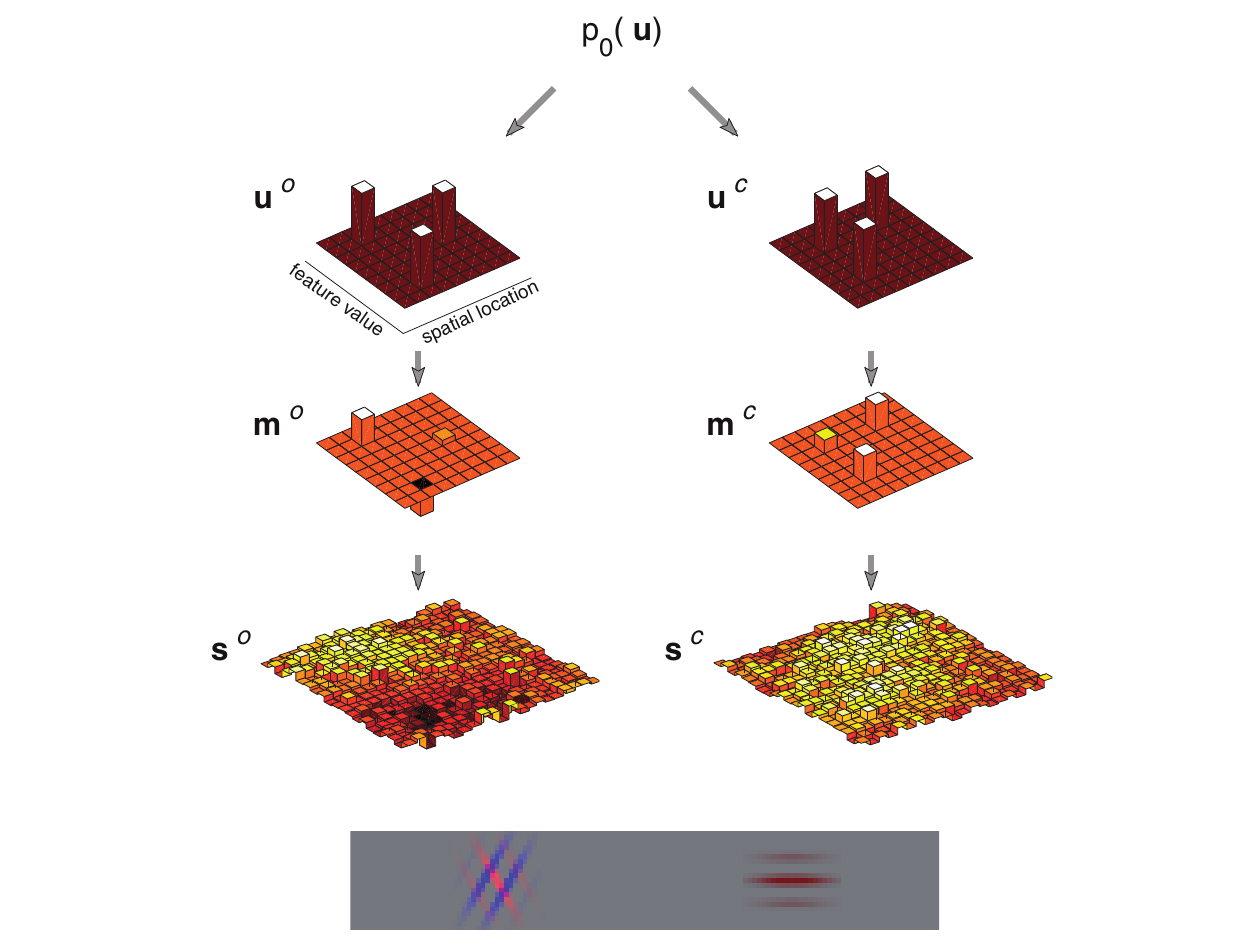
two objects), three orientations and two colors.The second row shows the associated feature maps ( m ), which include information about feature strength and polarity. Finally, the third row ( s ) shows the effective sensory cues, or observed information about the feature values.These are flattened and noisy, reflecting uncertainty in position, feature value, and strength, as might result from a brief presentation of the image and the incorporation of sensory